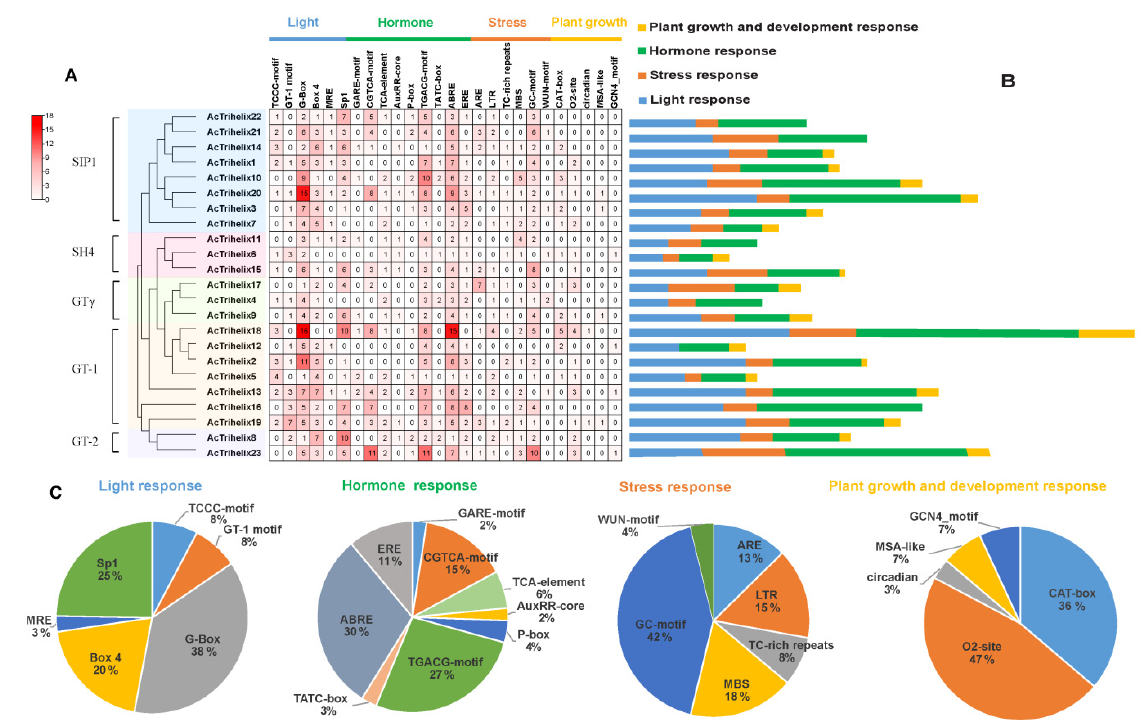
Figure 3. cis ‐ element analysis of AcTrihelix promoters: ( A ) the cis ‐ element analysis of Trihelix promoter region; ( B ) the numbers of different types of elements of AcTrihelix promoters were counted and are indicated by different colors; ( C ) the pie chart shows the proportion of each cis ‐ element of the four types of response elements.